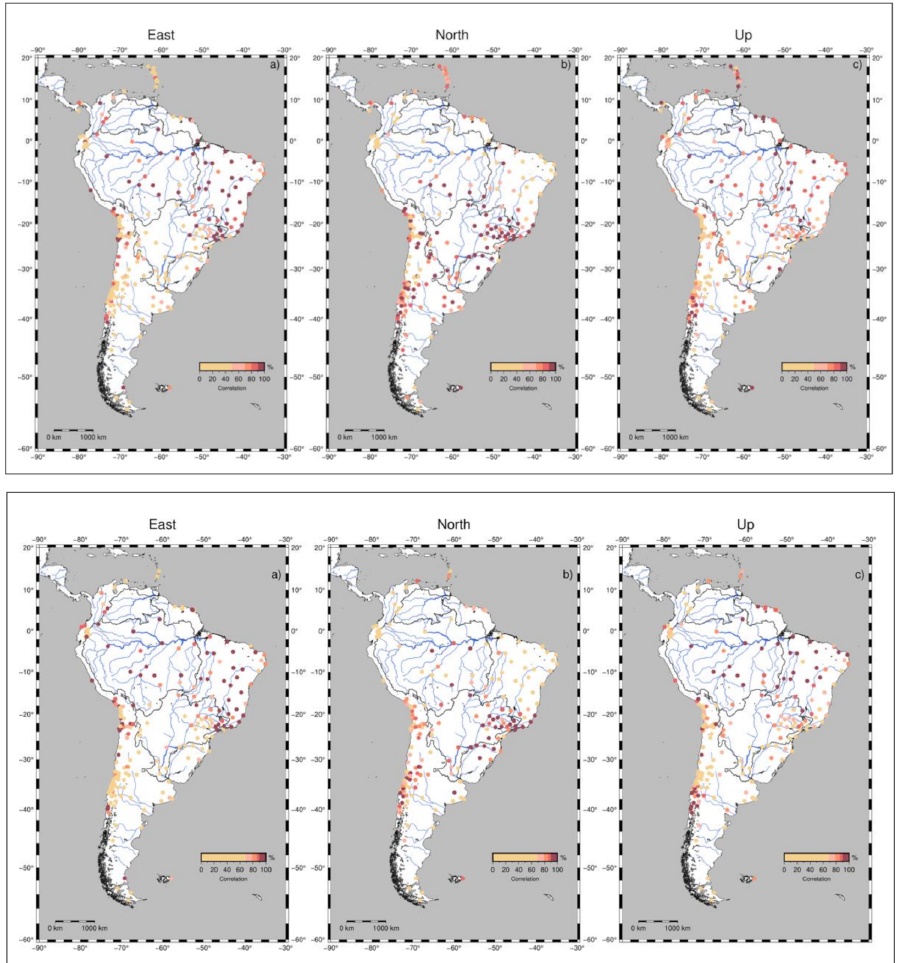
Figure 12. Map of the correlation coefficient (in %) between the GPS time series and the esti- mated loading time series using GLDAS/Noah hydrology model for the different GPS sites and each component ( a ) East, ( b ) North, and ( c ) Up. Top panel: correlation coefficient for the ini- tial model (ATMMO+GLDAS/Noah). Bottom panel: correlation coefficient for the new model (ATMMO+GLDAS/Noah +